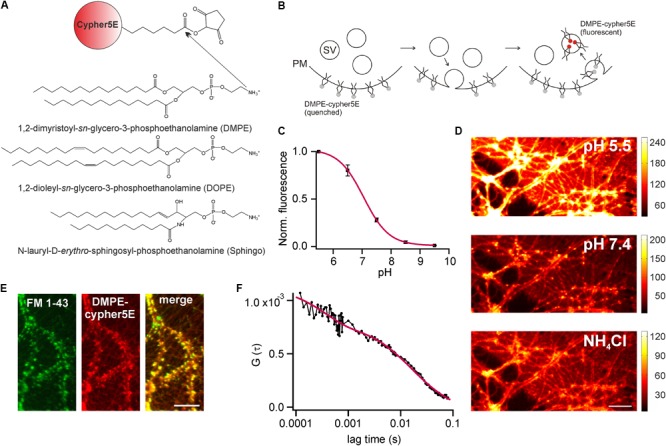
DMPE-cypHer5E stains synaptic vesicles (SVs) in primary hippocampal neurons. (A) Principle of lipid-dye coupling: The NHS-ester of cypHer5E was coupled to the primary amine of different lipids in organic phase. Unreacted dye was removed by thin-layer chromatography. (B) Schematic illustration depicting fluorescence changes of DMPE-cypHer5E during SV recycling. PM, plasma membrane; SV, synaptic vesicle. (C) Average normalized membrane fluorescence of hippocampal neurons stained with DMPE-cypHer5E as a function of pH (n = 3 coverslips, 10 ROIs each). Solid line represents a fit to a Henderson–Hasselbalch equation resulting in a pK of 7.1. (D) Neurons stained with pH-sensitive DMPE-cypHer5E displayed a highly fluorescent plasma membrane at acidic pH. After loading of SVs with DMPE-cypher5E (20 min network activity at 37°C and subsequent stimulation with 900 APs at 20 Hz), imaging at pH 7.4 revealed a punctate pattern of fluorescence that was quenched by superfusion with NH4Cl. Scale bar: 10 μm. (E) Co-localization of FM 1-43 and DMPE-cypHer5E fluorescence signals. Scale bar: 10 μm. (F) Average autocorrelation curves (n = 6) of DMPE-cypHer5E in the plasma membrane of immature neuronal cultures at pH 5.5. Solid red line represents fit to a 2D-diffusion model with an additional term accounting for the fast decay at low correlation times (N [number of molecules in confocal volume] = 1189, τD [diffusion time] = 16.4 ms, τc [chemical relaxation time] = 350 μs, P [chemically induced dark fraction] = 0.29). The estimated diffusion time corresponds to a diffusion coefficient of 1.3 μm2 s-1, in good agreement with earlier estimates for phospholipid mobility in neuronal membranes (Renner et al., 2009). Error bars represent SEM.